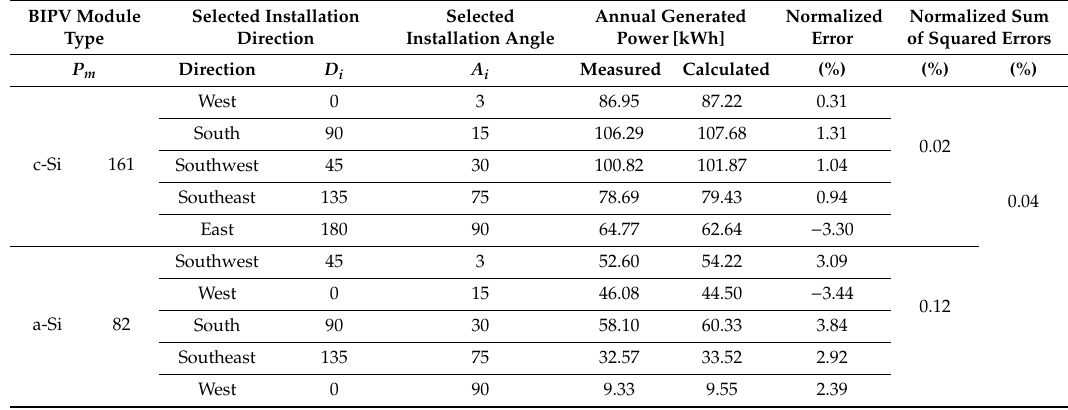
Table 9. Comparison of the annual generated power values for the cases measured from the mock-up and predicted by Equation